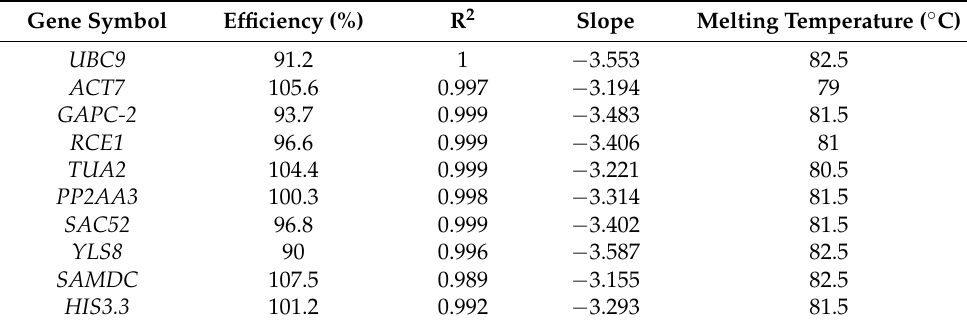
Table 2. Amplification efficiencies, correlation coefficients (R 2 ), slope and melting temperature of qPCR primers of ten candidate reference